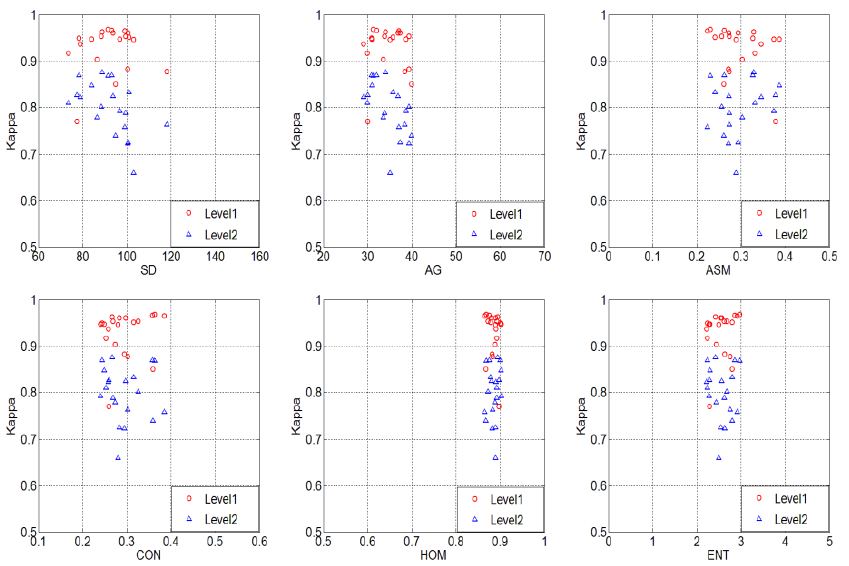
Figure 4. The relationship of the quality index and classification accuracy in different semantic hierarchies.